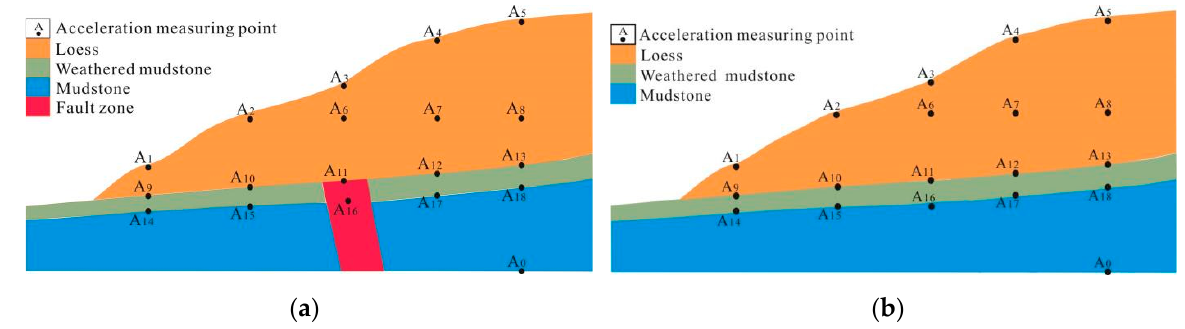
Figure 12. The numerical calculation model of loess-mudstone slope (LMS) ( a ) with a high anti-dip angle fault zone (HADAFZ) of 80° and ( b ) without the fault zone. Table 6. Basic parameters for numerical calculation.